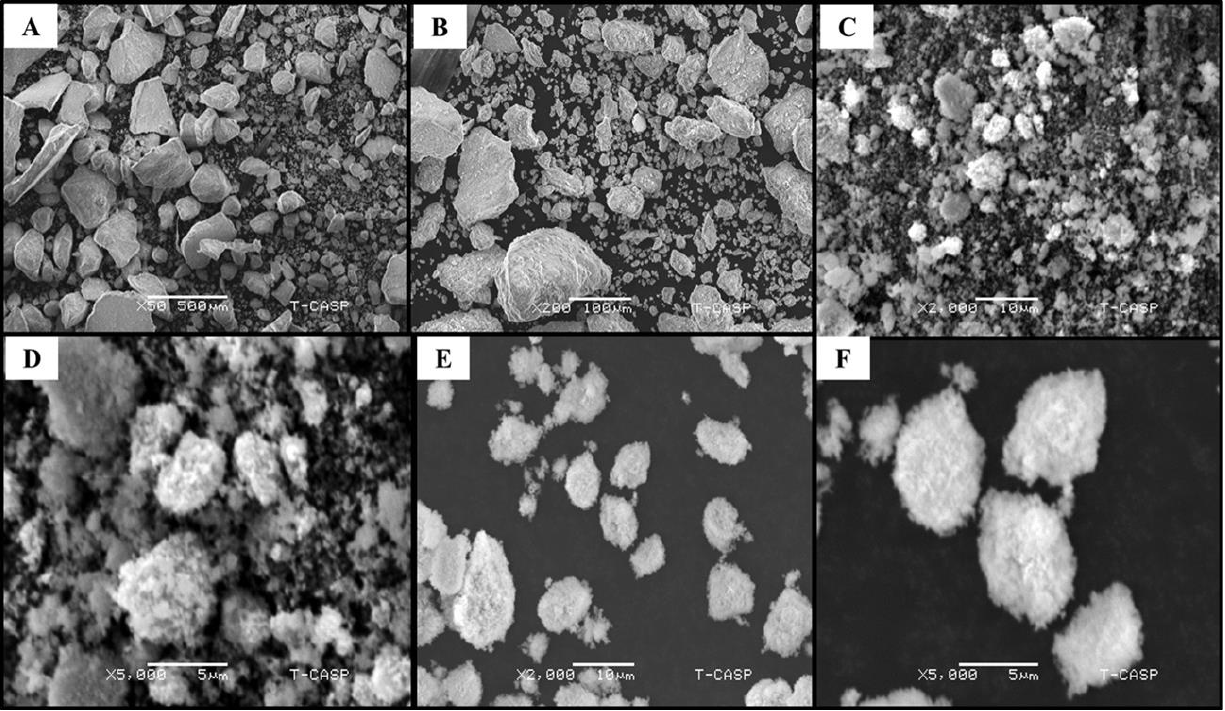
Figure 3. SEM images of ZnONPs. ( A , B ) CE-ZnONPs at ×50 magnification (500 µm) and ×200 (100 µm) ( C , D ) CE-UV-A-ZnONPs at ×2000 magnification (10 µm) and ×5000 (5 µm) ( E , F ) CE-UV-C-ZnONPs at ×2000 magnification (10 µm) and ×5000 (5 µm).